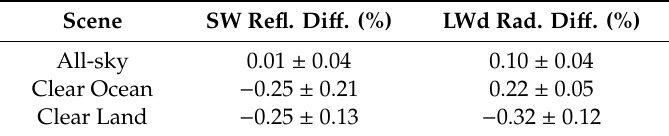
Table 4. Di ff erences in the global average of SW reflectance and daytime LW (LWd) radiance between SNPP / FM5 after radiometric scaling and Aqua / FM3 Edition-4, for 2014 for the three scenes considered. Di ff erences shown are FM5-FM3, as a percentage along with the 95% confidence intervals. Scene SW Refl. Di ff . (%) LWd Rad. Di ff . (%)